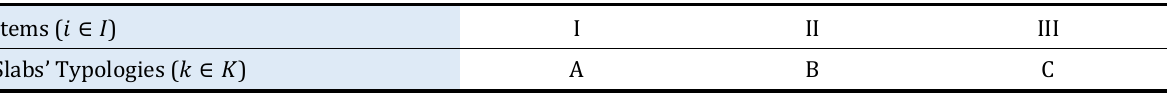
Fig. 3. An example of order: typology-based candidate sets case